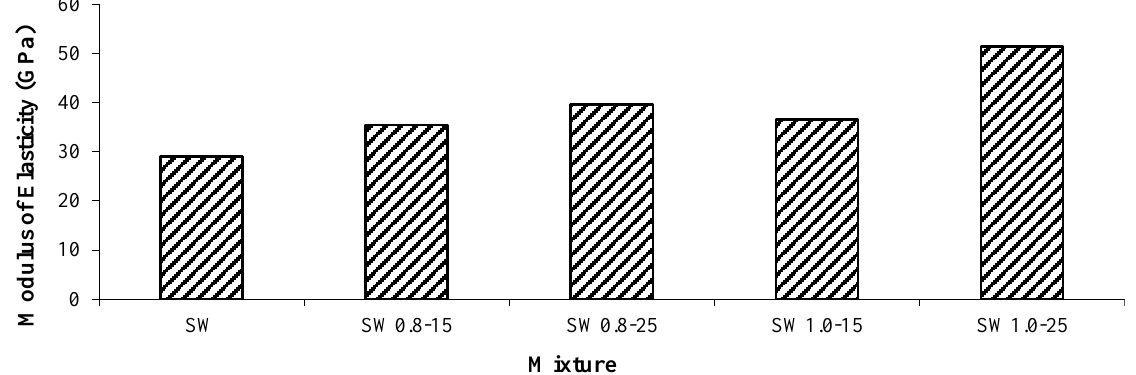
Fig. 4. Comparison of elastic modulus of CFCSF mixtures with reference